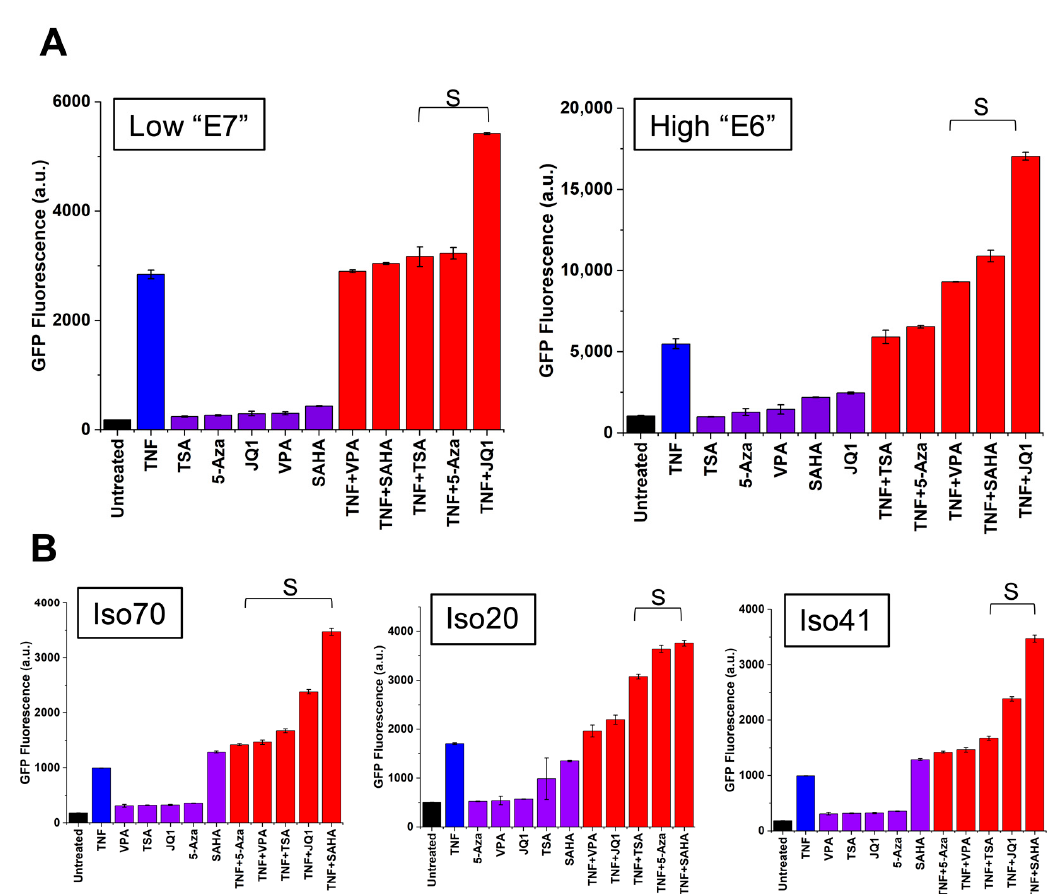
Figure 2. Chromatin modifiers synergize with TNF to activate the HIV promoter in monocytes. ( A ) To test if chromatin modifiers synergize with TNF to activate the HIV LTR promoter in monocytes, Ld 2 G THP-1 cells were exposed to TNF, four known chromatin modifiers (JQ1, suberoylanilide hydroxamic acid (SAHA), trichostatin A (TSA), and valproic acid (VPA)), and their combination treatments. The combination treatment between TNF and JQ1 shows the greatest synergistic activation of the LTR promoter in Ld2G monocytes across different genomic integrations, as evidenced by the non-additive increase in GFP fluorescence (<GFP FL>). Synergy was calculated from EoB. “S” denotes synergy. Experiments were performed in duplicate and mean and standard error were plotted. ( B ) To confirm LTR promoter activation across cell types, we subjected Ld 2 G Jurkat cell lines to treatments with TNF and chromatin modifiers. In a low expressing cell line, all combinations between TNF and chromatin modifiers synergize to enhance HIV expression (Left). Three chromatin modifiers (TSA, JQ1, and SAHA) similarly synergized with TNF to enhance LTR activation in a high expressing clone (Right). Synergy was calculated from EoB. “S” denotes synergy. Experiments were performed in duplicate and mean and standard error were